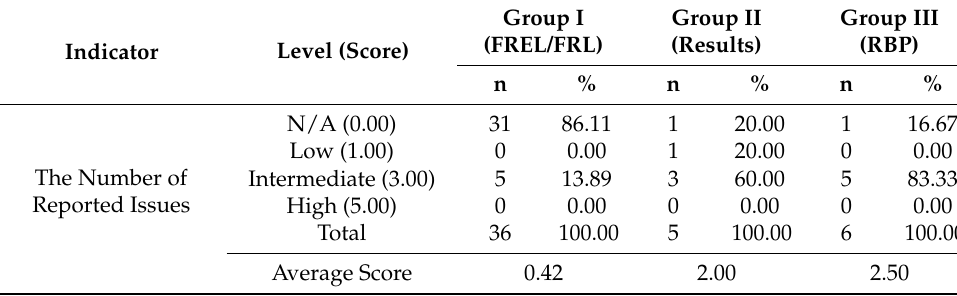
Table 5. Results of MRV capacity evaluation on national